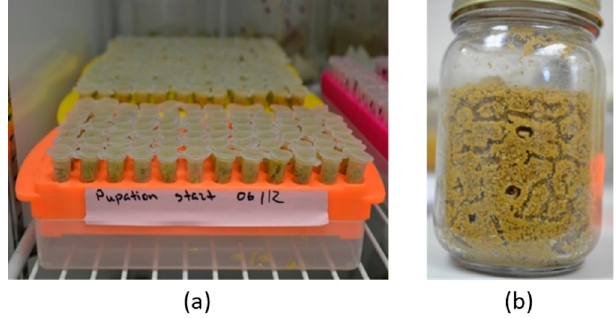
Figure 1. Small hive beetle (SHB) individual and mass pupation approaches: ( a ) tube trays containing Eppendorf tubes with individually pupating larvae; ( b ) a pupation jar containing 30 pupating larvae.